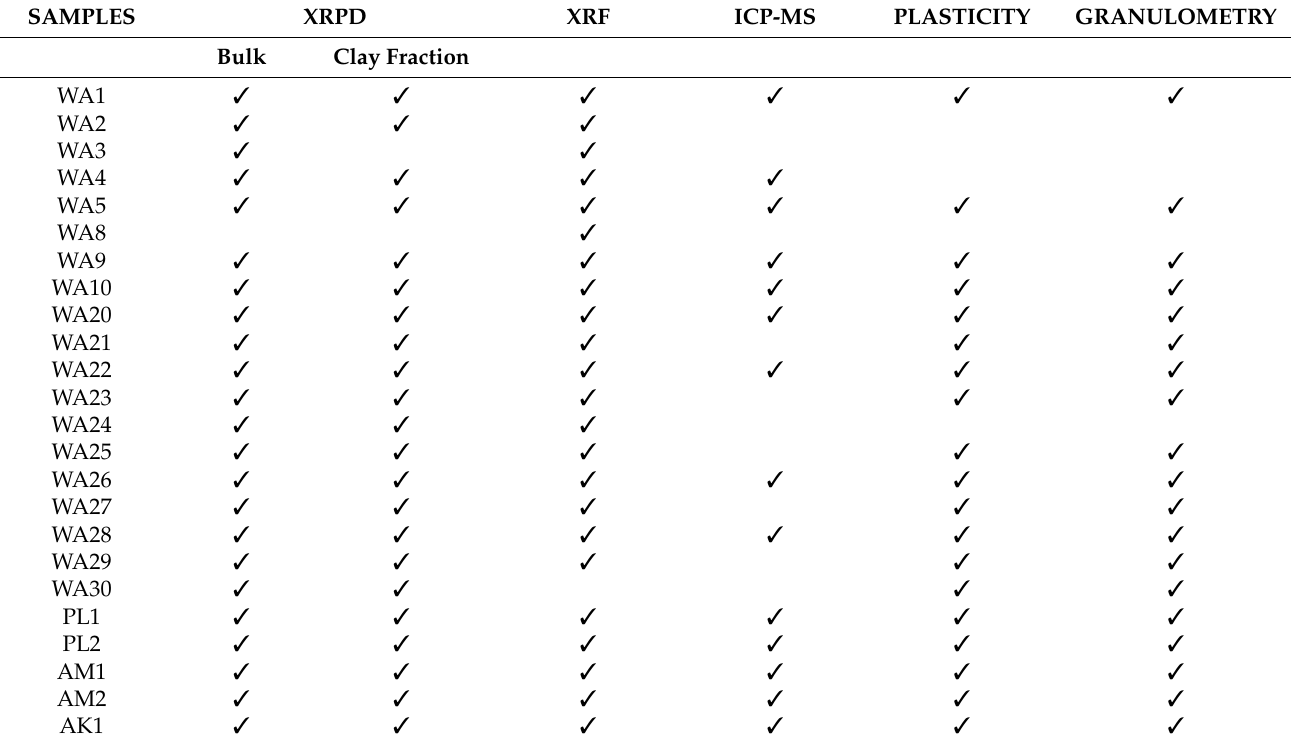
Table A5. List of the studied samples and the analytical techniques and methods